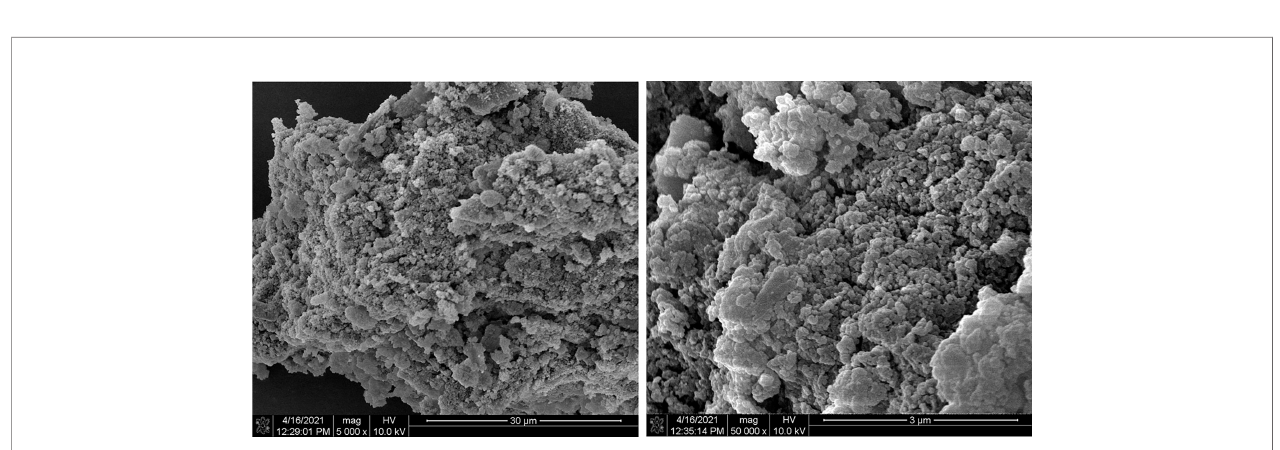
FIGURE 1 | A combination of instrumentation analysis and chemistry analyses of SPSP. (A) HPGPC analysis of SPSP. (B) monosaccharide composition of SPSP. (C) FT-IR spectrum. (D) XRD spectroscopy of SPSP fi